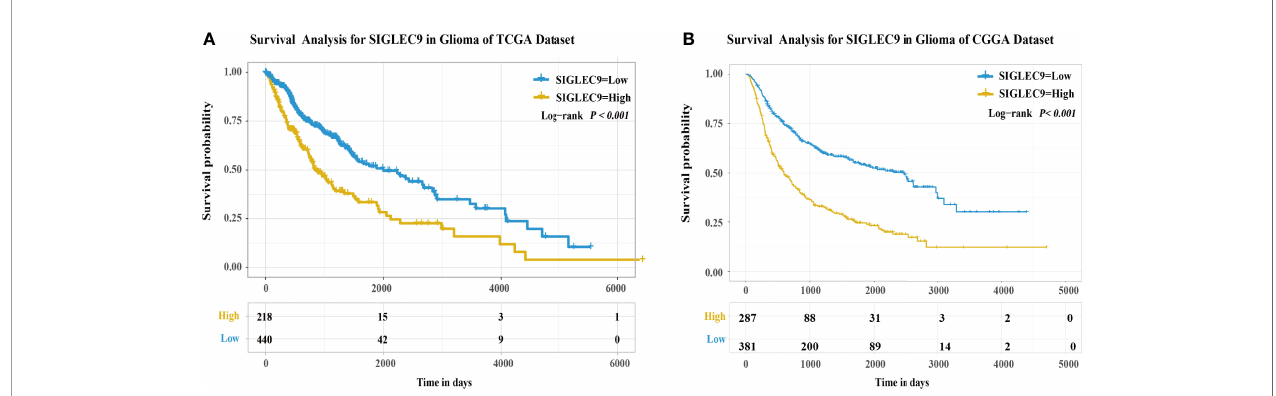
FIGURE 2 | The expression of SIGLEC9 in gliomas with The Cancer Genome Atlas (TCGA) and the Chinese Glioma Genome Atlas (CGGA) databases. (A) In TCGA database, the glioma patients with a high SIGLEC9 expression ( n = 218) had a shorter survival probability than those patients with a low SIGLEC9 expression ( n = 440) ( P < 0.001). (B) In the CGGA database, the glioma patients with a high SIGLEC9 expression ( n = 287) had a shorter survival probability than those patients with a low SIGLEC9 expression ( n = 381) ( P <